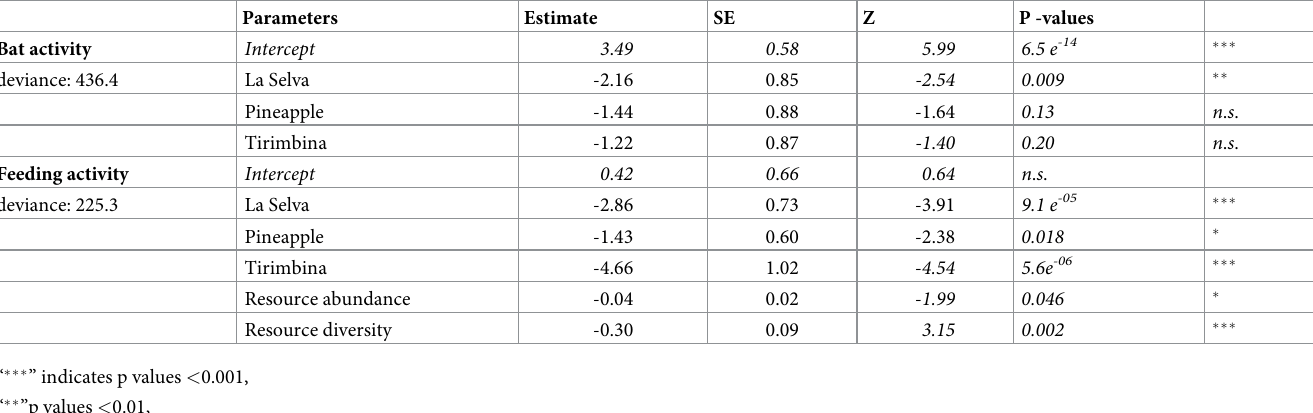
Table 3. Results of the generalized linear mixed effect models for bat activity and feeding